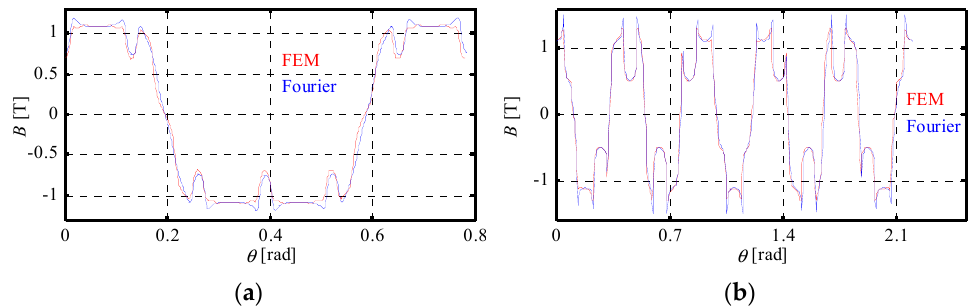
Figure 7. Flux density created by the magnets in the air gap in open-circuit condition: ( a ) Qs48p8, ( b ) Qs36p15.